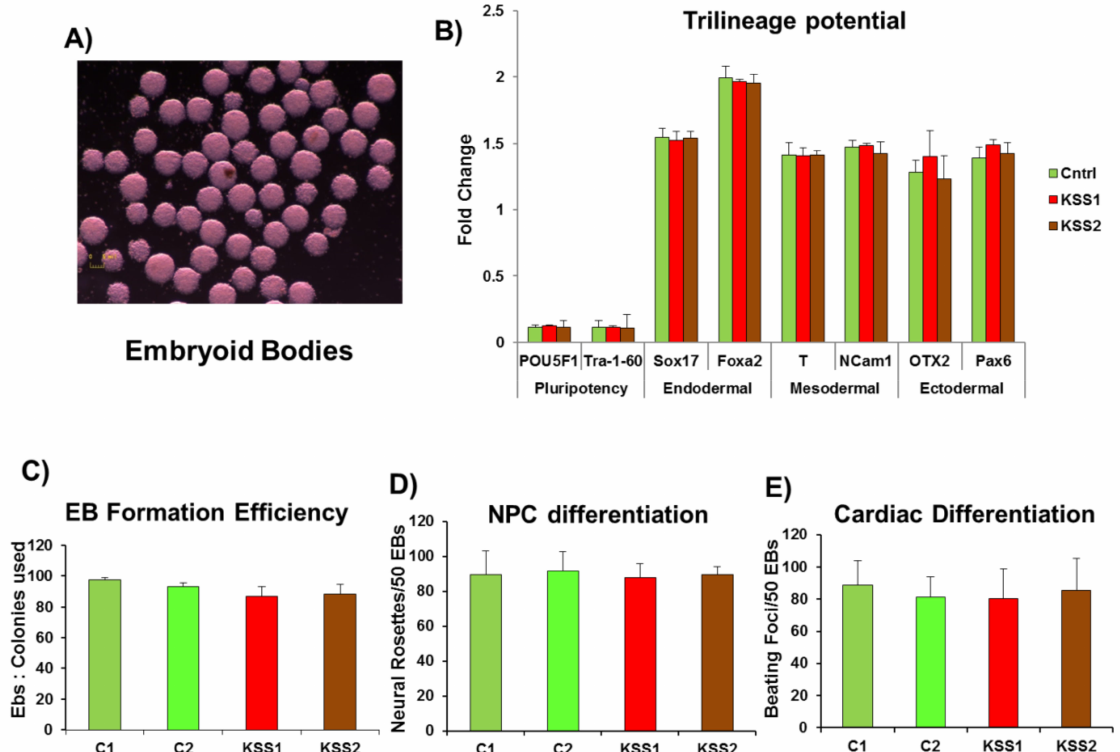
Figure 3. Assessment of trilineage and directed differentiation potential of induced pluripotent stem cells (iPSC). ( A ) Embryoid body suspension cultures showed uniform cellular clusters; ( B ) Trilineage differentiation potential was assessed through qPCR analysis for both (Kearns Sayre syndrome patients) KSS1 and KSS2 as well as healthy control PBMNC derived iPSC clones. ( C ) Embryoid body formation efficiency across controls and patients (KSS1 and KSS2) iPSC clones was found to be equivalent and consistent over passages; ( D ) Directed differentiation of iPSC to neural progenitor cells was carried out. ( E ) Directed differentiation of iPSC to cardiomyocytes was carried out. The differentiation potential of KSS1 and KSS2 peripheral blood mononuclear cells (PBMNC) derived iPSC clones toward neural progenitor cells and cardiomyocytes was comparable to control iPSC. n = 3, each experiment was repeated 3–4